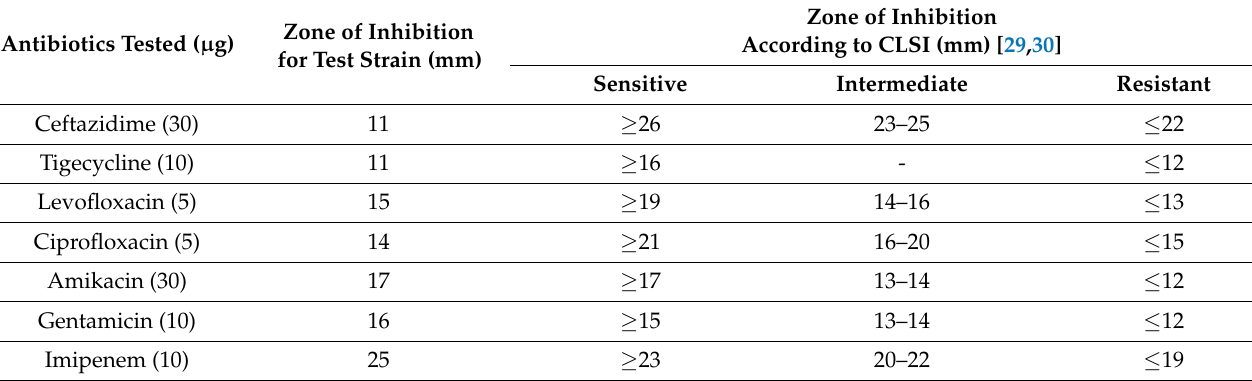
Table 2. Antibiotic susceptibility test results of S. typhi .